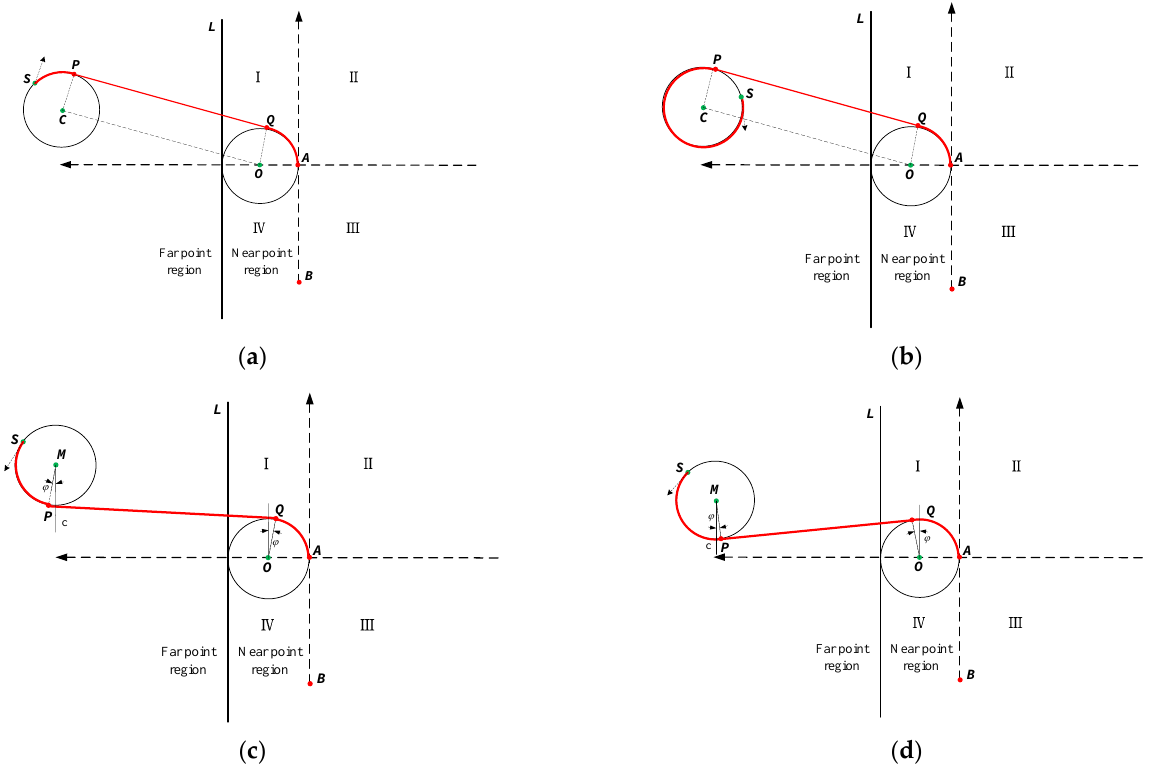
Figure 5. There are four routes in far point region I: ( a ) turning to starboard (route 1), ( b ) turning to starboard when the vessel is to the left of point P (route 1 (cid:48) ), ( c ) turning to port when y M ≥ y O + 2 R (route 2), and ( d ) turning to port when y M < y O + 2 R (route 2 (cid:48) ). In route 1, PQ || CO , CP ⊥ PQ , OQ ⊥ PQ , and PQ are tangent to circle O and circle C